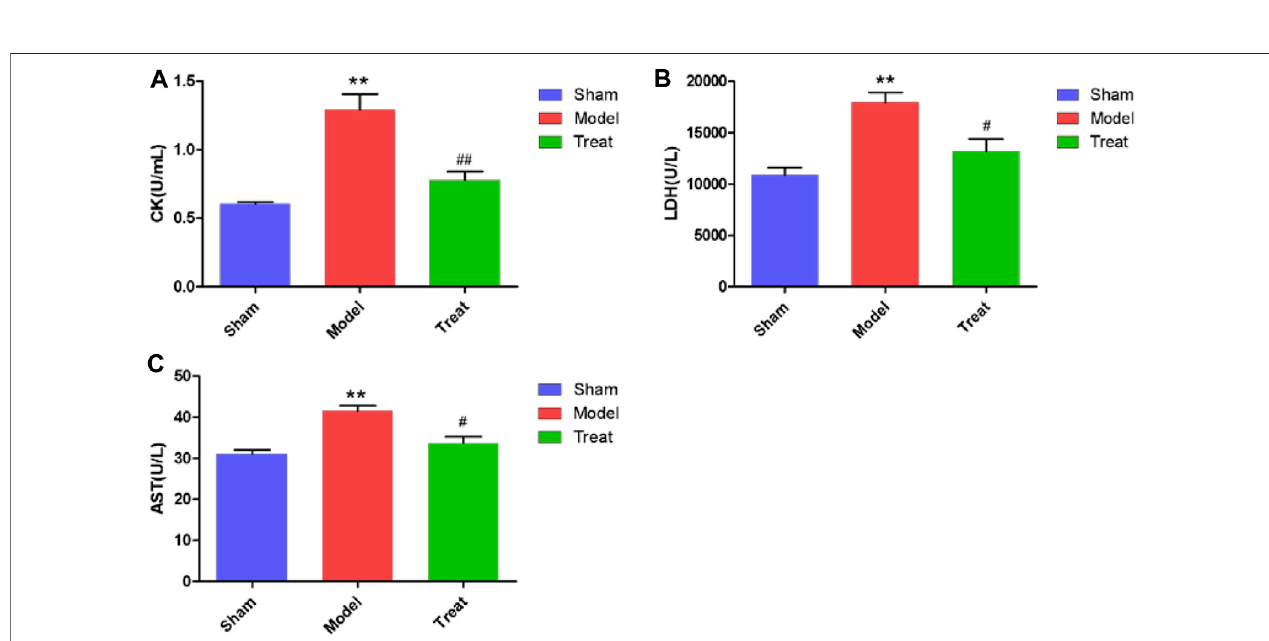
FIGURE2| CK,LDHandASTlevelsinShamgroup,ModelgroupandTreatgroup.Datawereexpressedasmean ± SD( n (cid:1) 6),* p < 0.05,** p < 0.01comparedwith the Sham group, # p < 0.05, ## p < 0.01 compared with the Model group.